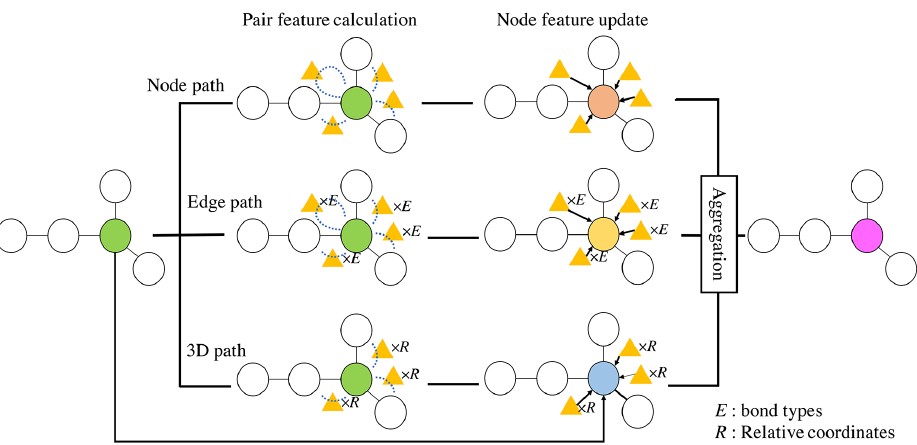
Figure 2. Overview of the proposed method. For simplicity, we illustrated the flow of feature update for a single attention node (green circle). Firstly, we generate pair features (yellow triangles) representing the relationship between the node and its neighbors. We use bond types and relative coordinates to extract edge relationships and three-dimensional structures. Then, we update the node features using the pair features (orange, yellow, and blue circles). Finally, we aggregate each path’s features of the attention node to obtain the node features, which are the output of this layer (purple circles). We repeat the above processes for feature